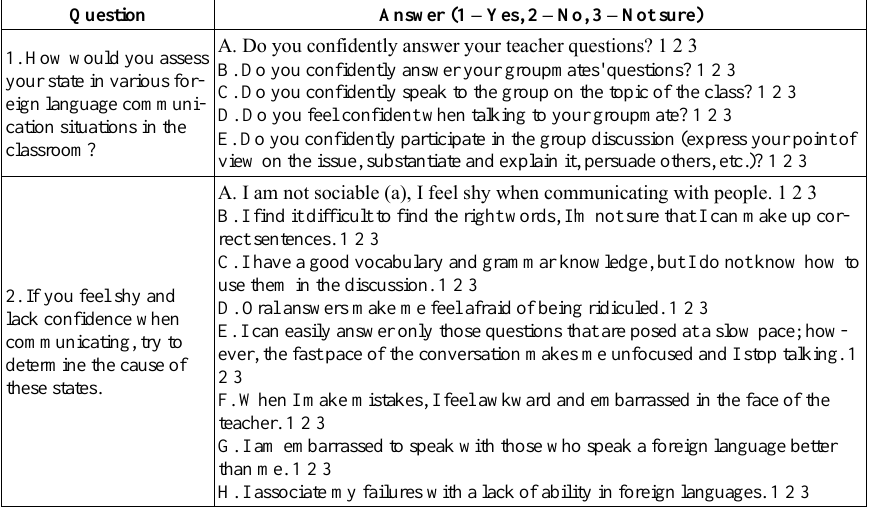
Table 2. Difficulties encountered in foreign language